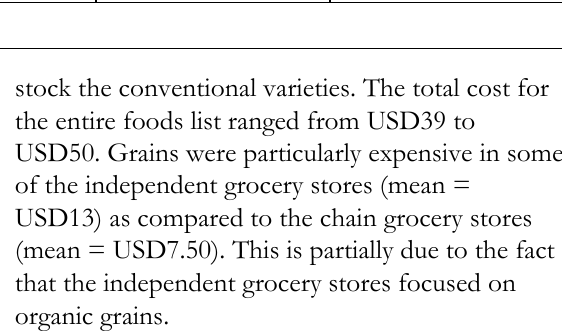
*Items in bold were included in price